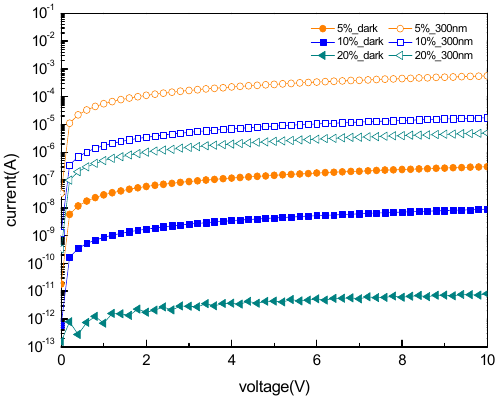
Figure 6. I-V characteristics for Au/IGO/Au, with varying oxygen partial pressure.